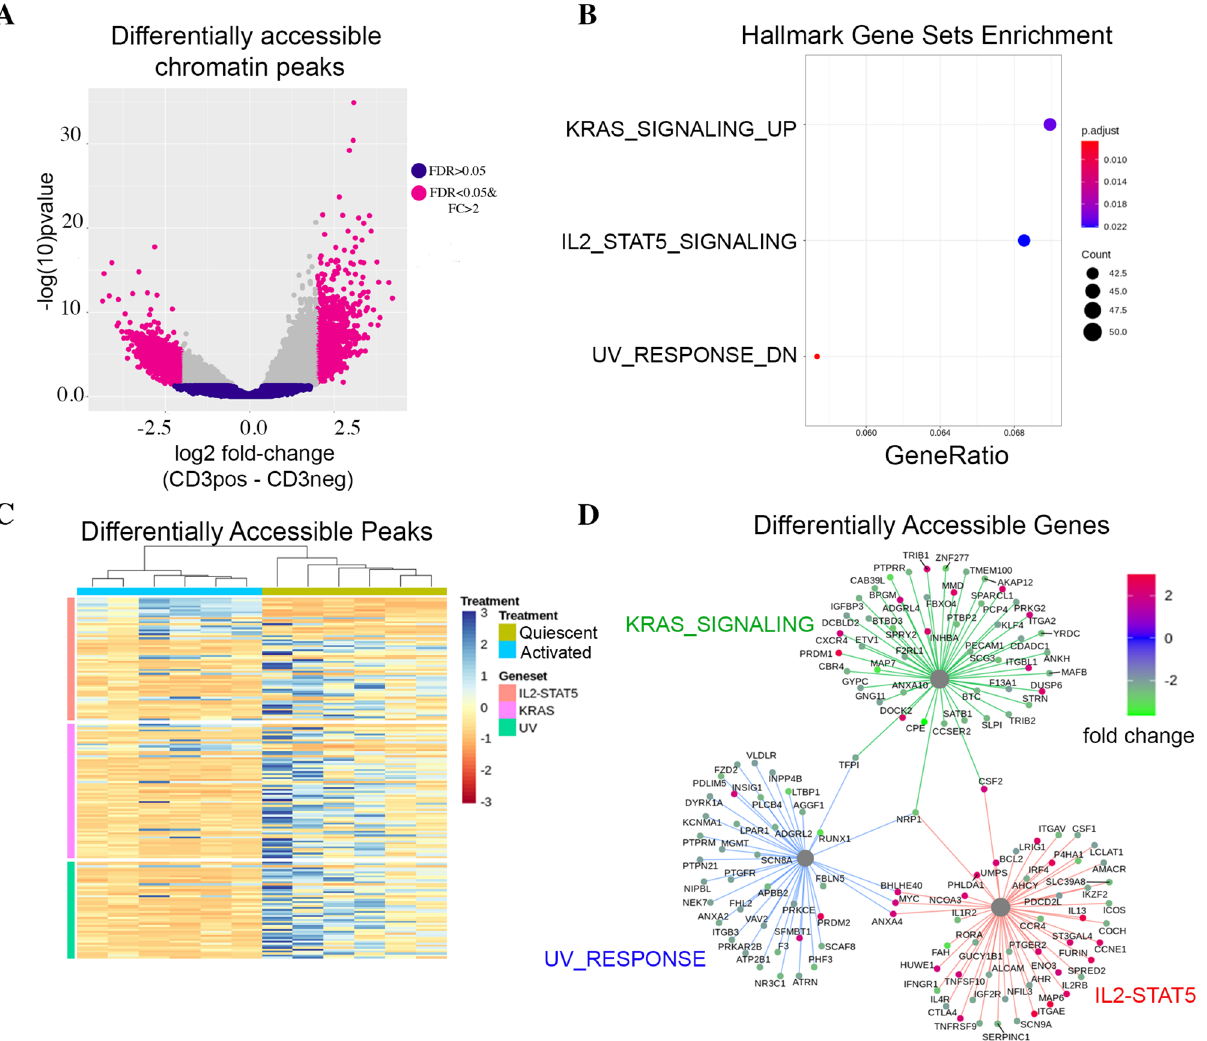
Figure 2. Differential accessibility of chromatin peaks in activated versus resting cells. (A) Volcano plot of differentially accessible peaks. Each data point represents a consensus peak. (B) Gene sets enrichment analysis of differentially accessible peaks. The dot plot shows significantly enriched pathways (hallmark collection) at the FDR < 0.05 level. (C) Cluster heatmap of 130 differentially accessible peaks annotated to enriched pathways. Rows represent peaks, columns represent samples. Cells are colored according to row-scaled read counts. Columns are clustered by Euclidean distance with complete linkage. (D) Gene concept network plots the links between differentially accessible genes (edges) and their associated enriched pathways (nodes). Edges are colored according to fold-change